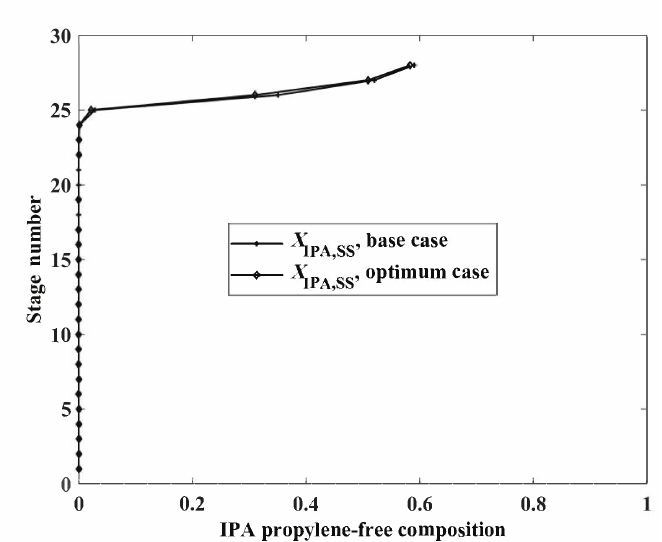
Fig. 6 – Comparison of profiles of water and IPA propyl- ene-free compositions through RD column at steady-state con- ditions for base case and optimum case. SS means